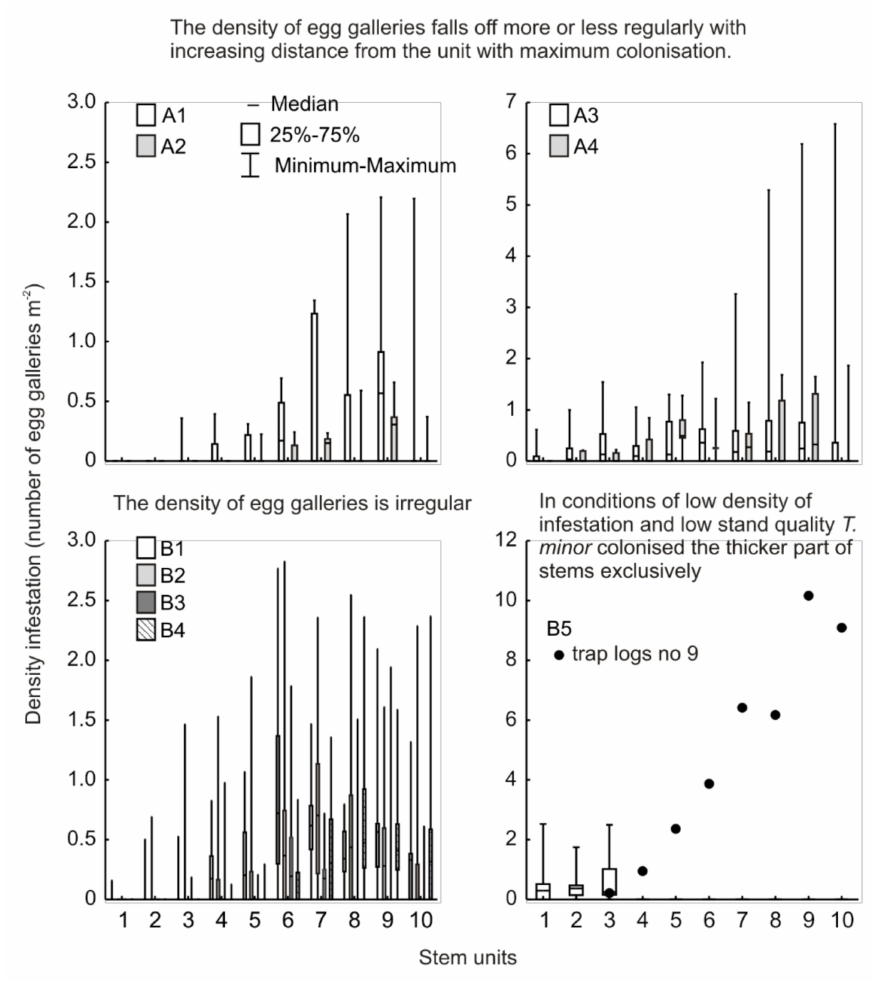
Figure 6. Colonization patterns of the trap logs units by T. minor